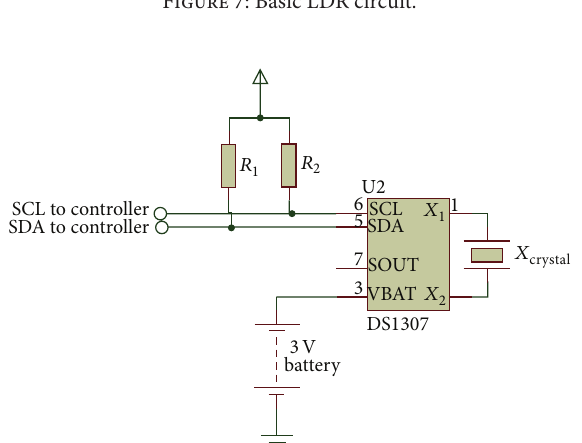
Figure 7: Basic LDR circuit.